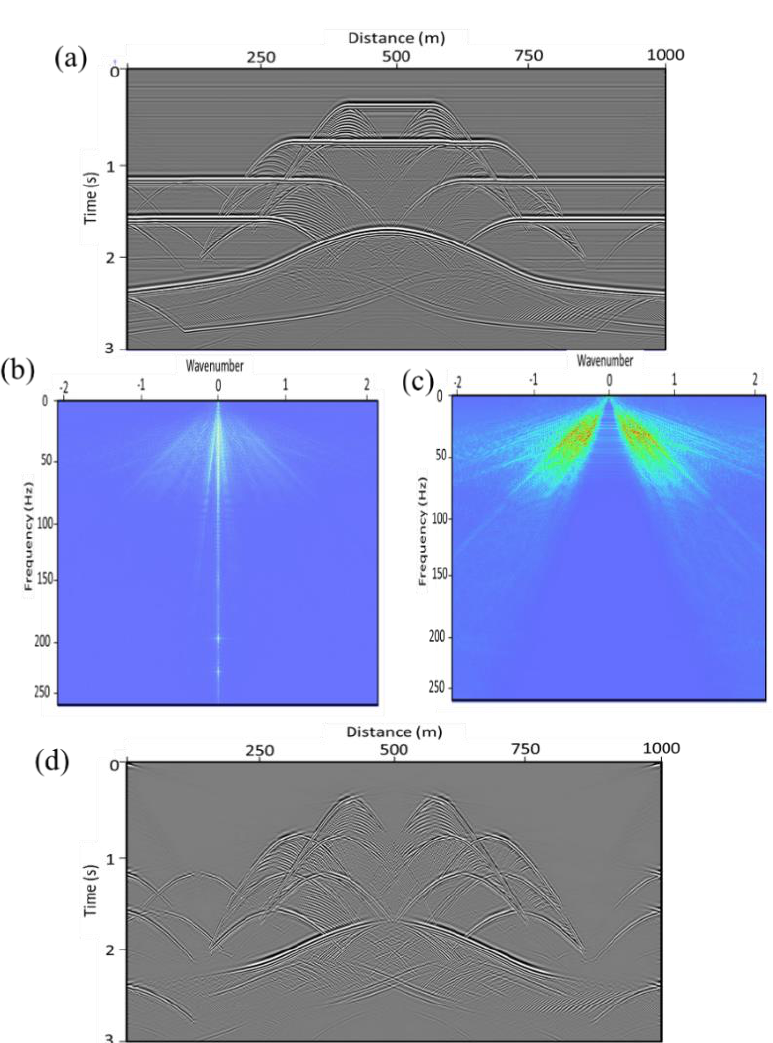
Figure 5. ( a ) Malay Basin field, which contains extensive faults and fractures in the igneous basement [28]. ( b ) Input initial velocity model for seismic analysis [8].